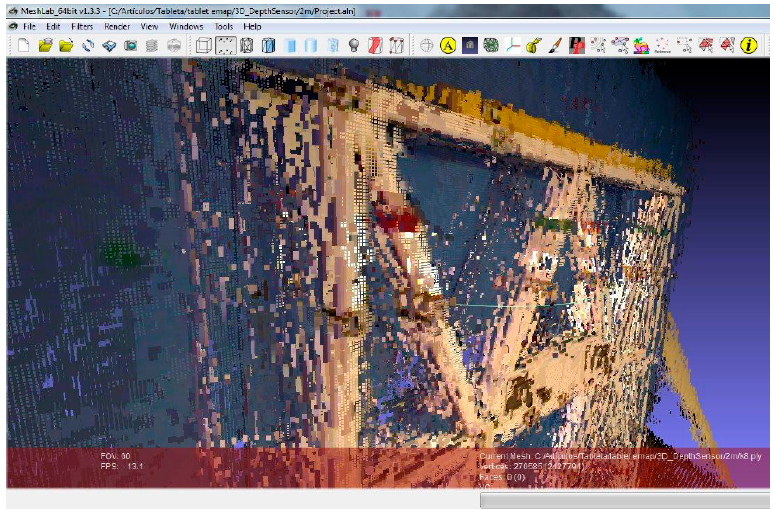
Figure 13. Erroneous point cloud obtained in the second experiment.